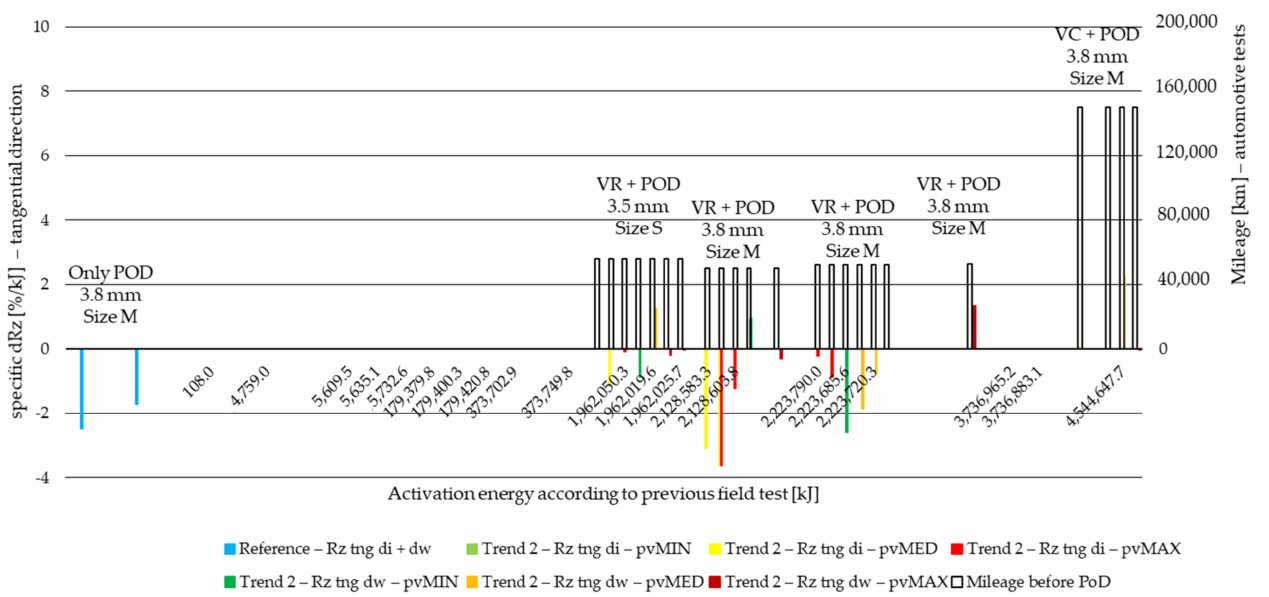
Figure A6. Tangential direction PoD specific Rmax difference values of cut material samples from inner and working diameter after minimum, medium and maximum pv level pin-on-disc tests with previous field-test (Table 2) mileage along Joule scale—Trend 1: clutch killer load cases.